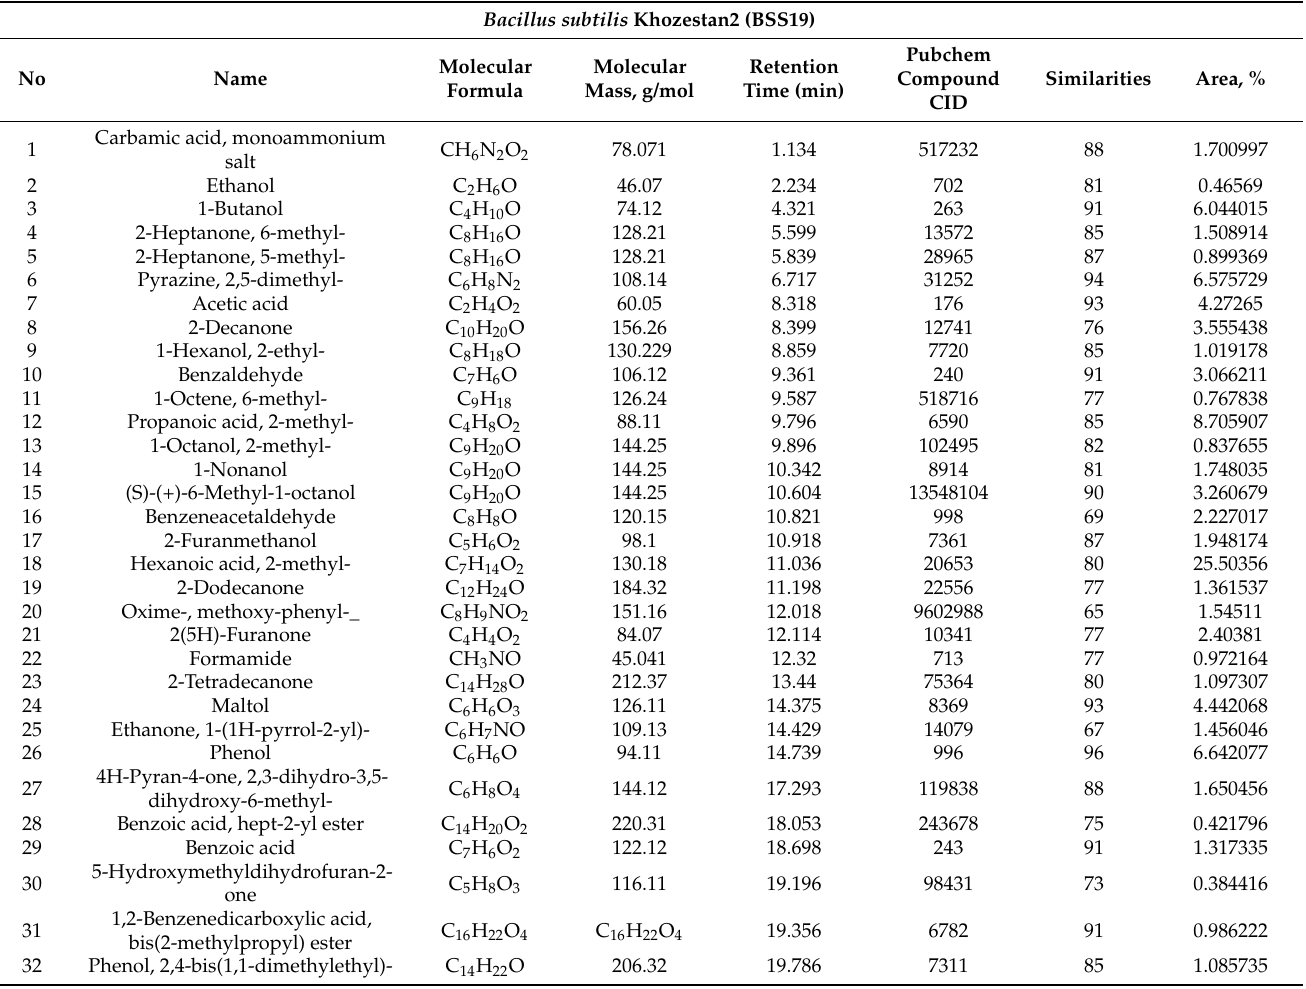
Table 6. The main constituents of bacterial extract BSS19 identified through a GC–MS